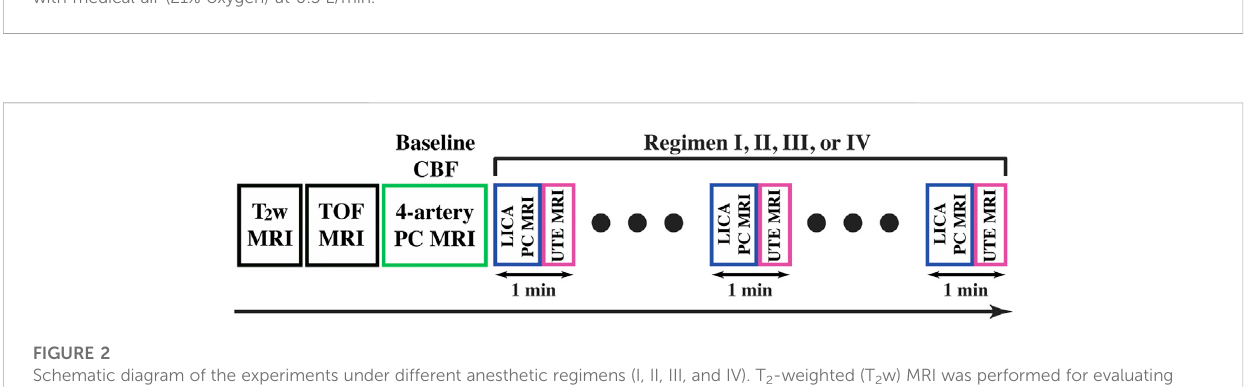
protocol (TR/TE = 4,000/26 ms, FOV = 15 × 15 mm 2 , matrix size =